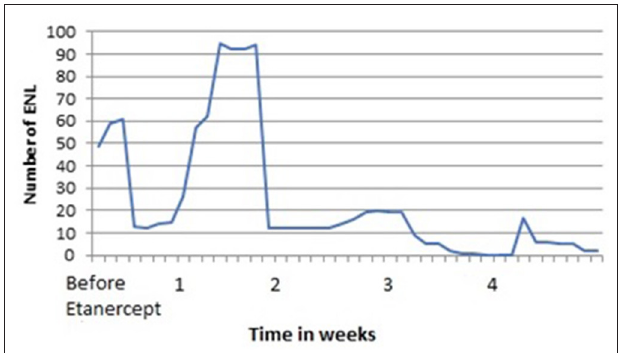
FIGURE 1 | Behavior of the reduction of ENL after etanercept therapy in Patient 1.